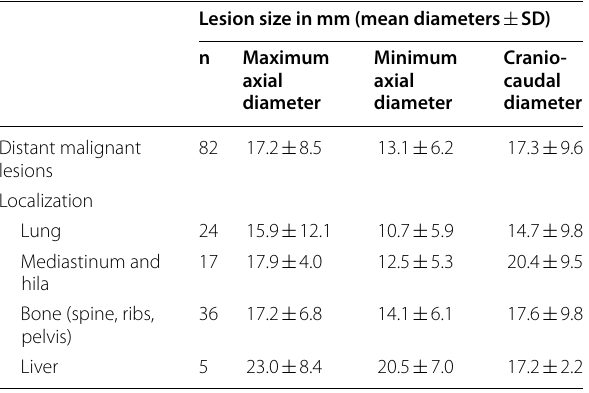
Second primary cancers were located in the lung/hila ( n (